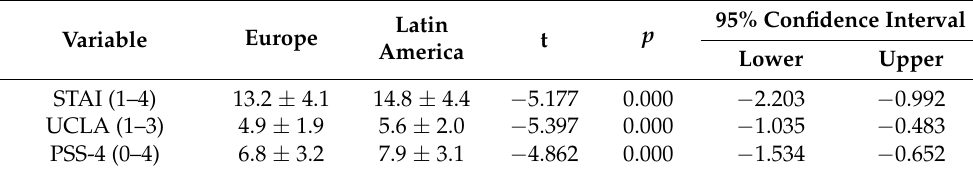
Table 2. Differences between regions of the psychological profile of